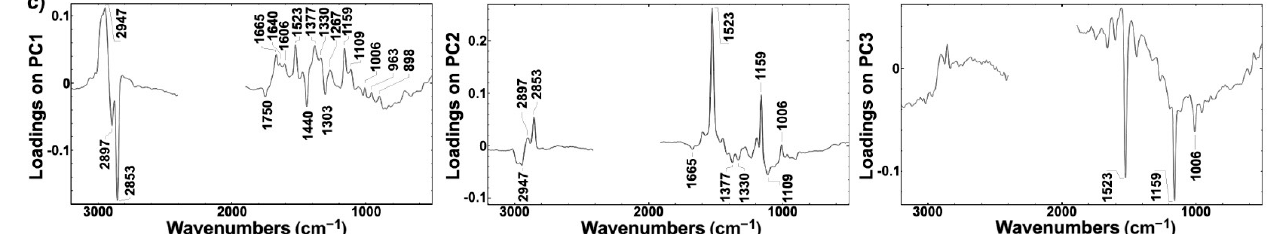
Figure 7. PCA of FT-Raman spectra of fungi grown at different phosphates and calcium concentrations. ( a ) Score plots of PC1 and PC2, ( b ) PC2 and PC3, and ( c ) the first three loading vectors. Score plots are labeled according to strains: Amylomyces rouxii ( Ar ), Mucor circinelloides VI 04473 ( Mc1 ), Mucor circinelloides FRR 5020 ( Mc2 ), Mucor racemosus ( Mr ), Rhizopus stolonifer ( Rs ), and Umbelopsis vinacea ( Uv ) (left), phosphates concentrations (middle), and calcium availability (right). Vectors are approximating the increase in relative amount of the metabolites: lipids (L), cell wall carbohydrates (C), and carotenoids (Cr). The explained variances for the first five principal components are 47.3%, 26.9%, 15.8%, 3.8%, and 1.4%.